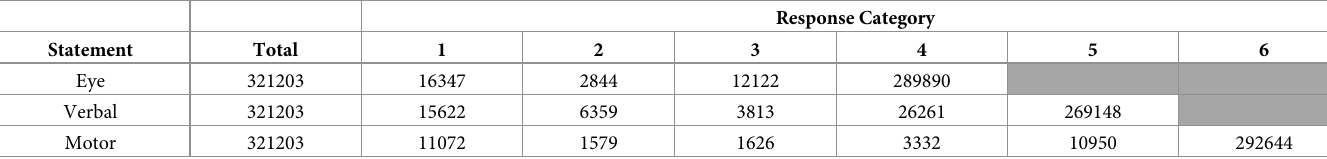
Table 2. Response category frequencies (n) for the individual items (sub-scales) of the Glasgow Coma